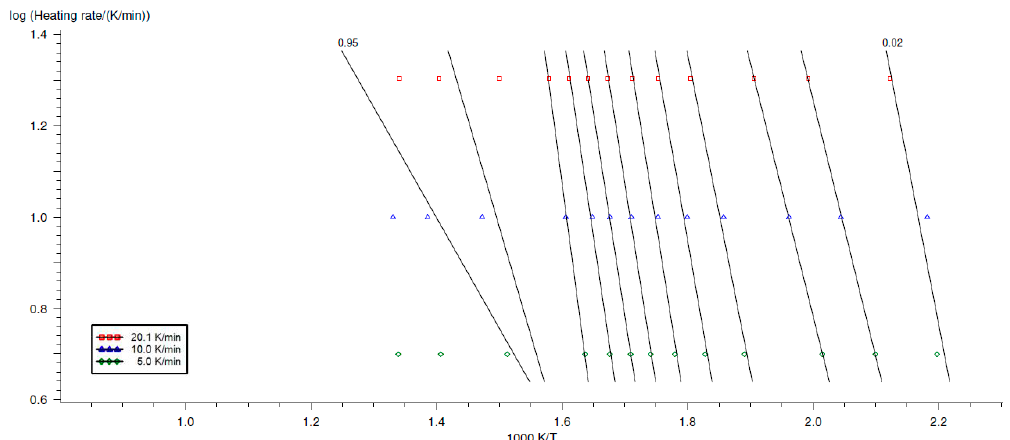
Figure 6. Graph of dx/dt logarithm as a function of temperature inverse of Ozawa–Flynn–Wall method for a maize straw sample.